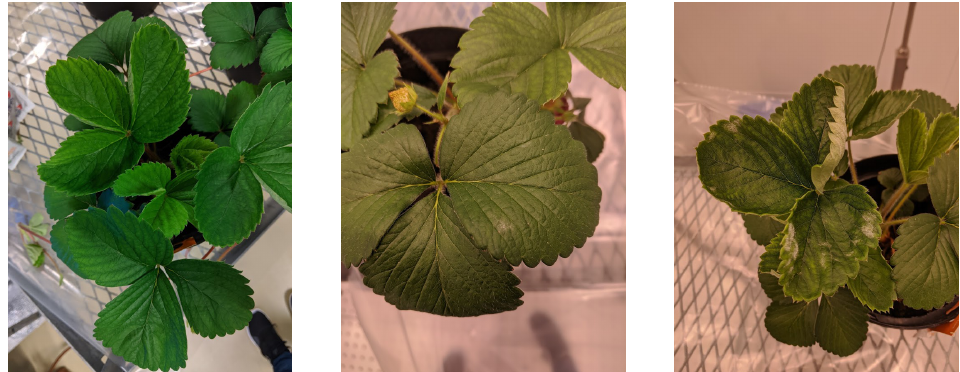
Figure 3. Powdery mildew infected plants; left—reference plant without visual symptom, middle— infected level 1, and right—infected level 2.